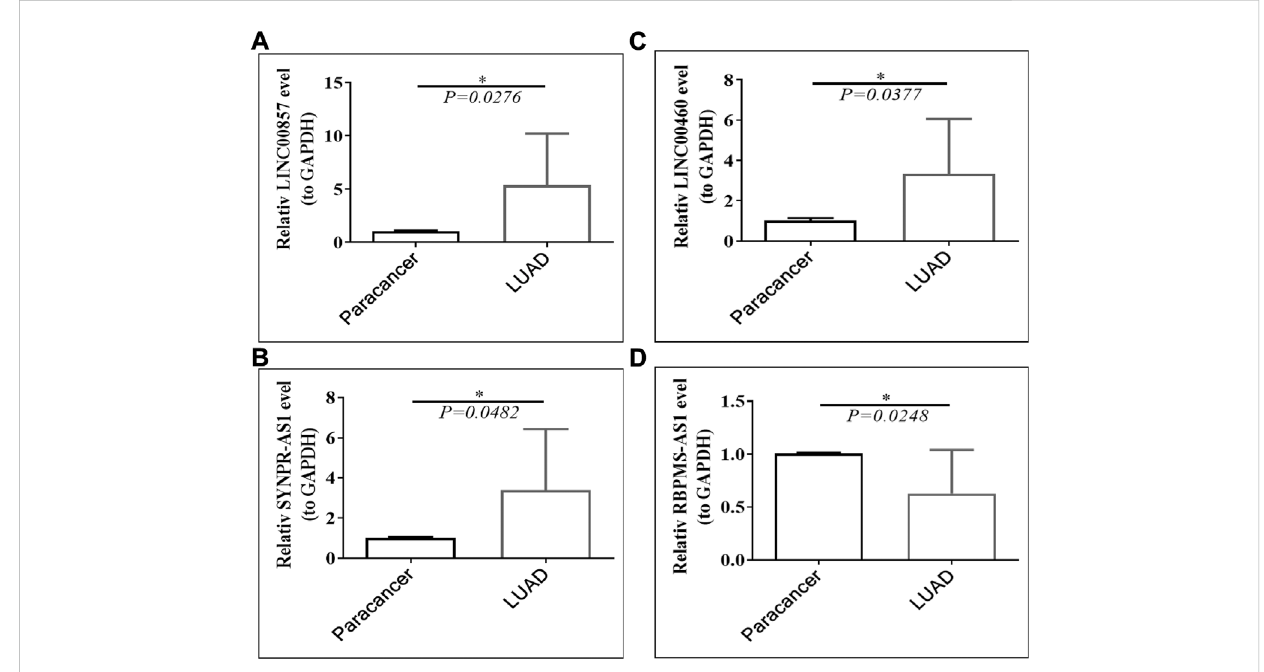
FIGURE 13 Expression of (A) LINC00857, (B) SYNPR-AS1, (C) LINC00460 and (D) RBPMS-AS1 in LUAD tissues and paraneoplastic tissues.